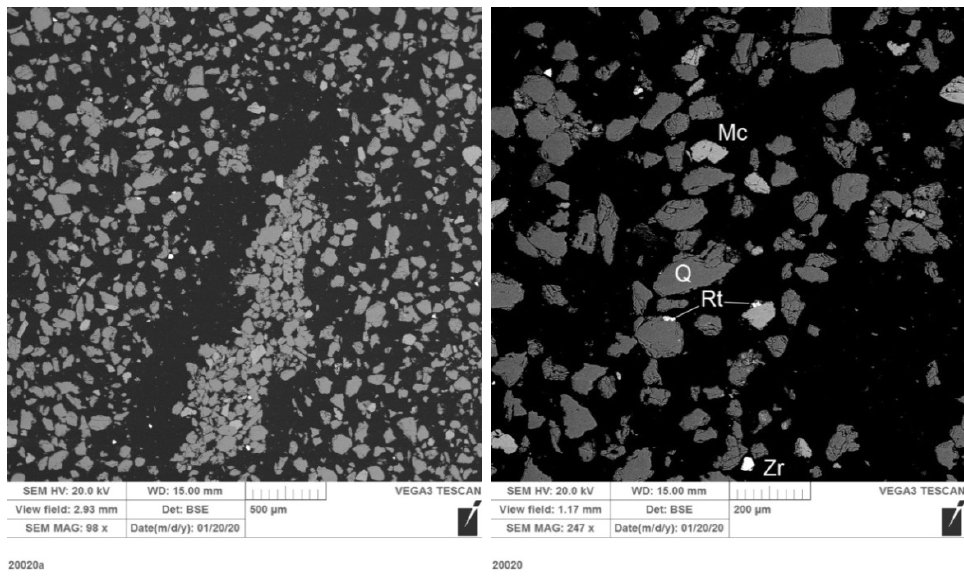
Figure A2. SEM micrograph of Sample GGS2-11-2. Quartz (Q)-potassium feldspar (Mc) aggregate (orthoclase or microcline) with mica cement (not marked, there is very little of it) and accessories: zircon (Zr), titanium oxide (Rt). No calcium carbonates were found in the cement. Mica cement (illite) is enriched with magnesium.